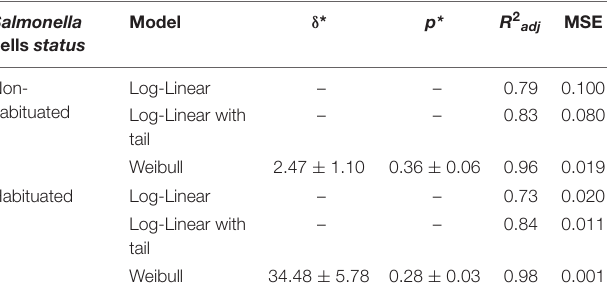
TABLE 1 | Statistical goodness-of-fit and Weibull model parameters for UV-C Salmonella Typhimurium inactivation in dry-fermented sausages. Salmonella cells status